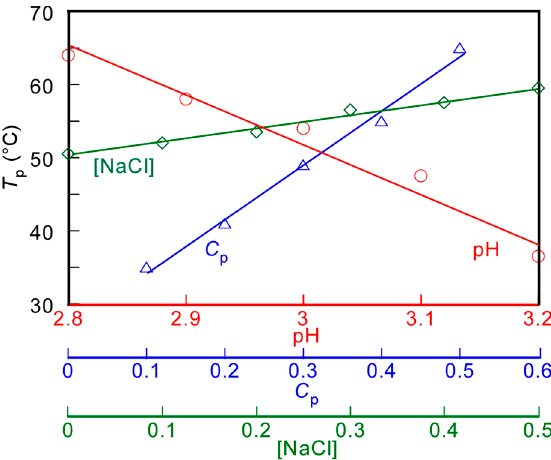
Figure 5. pH ( ○ ), polymer concentration ( C p , △ ), and salt concentration ([NaCl], ◇ ) dependence on the phase transition temperature ( T p ) for aqueous PMPC/PAAc solutions with f AAc = 0.85.